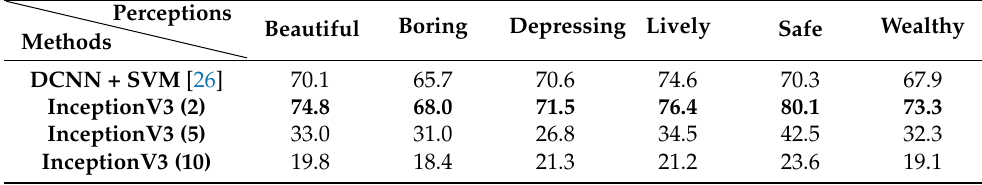
Table 4. Performance of the classification models (ACC).